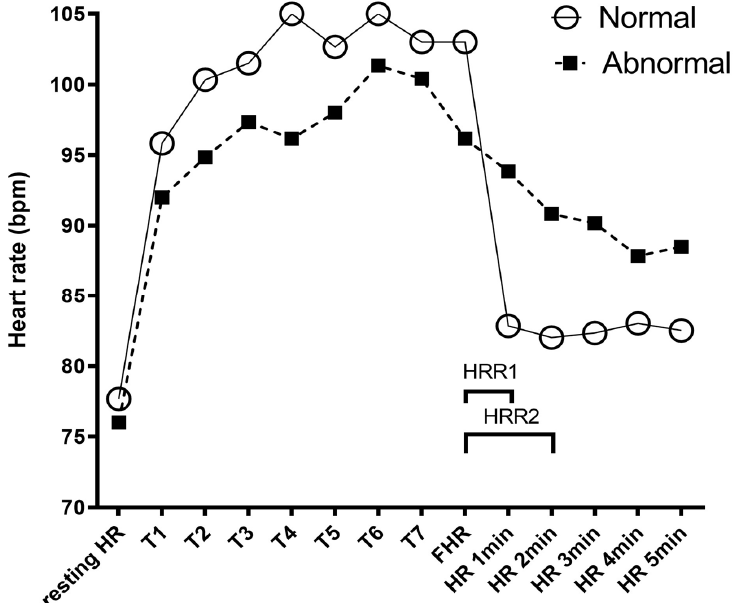
Figure 1. Representative graph of the heart rate (HR) evaluation during the 6-min walking test (6MWT). Resting-HR and oxygen saturation (SpO2) were recorded before the 6MWT with a pulse oximeter. After each turn (T), HR and SpO2 were recorded. The open circles show the HR of healthy patients throughout the 6MWT. The black squares show the HR of patients with abnormal heart rate recovery (HRR). At the end of the 6MWT, we recorded the final heart rate (FHR) and then recorded the HR each minute during the 5 following minutes. Heart rate recovery at the first minute (HRR1) was defined as FHR minus HR1min and HRR2 was calculated in the same way. To establish categorical abnormal HRR1 (aHRR) and HRR2 (aHRR), the first quartile of all the data, ≤ 8, and ≤ 11 bpm was used as cutoff point for worsening, respectively.